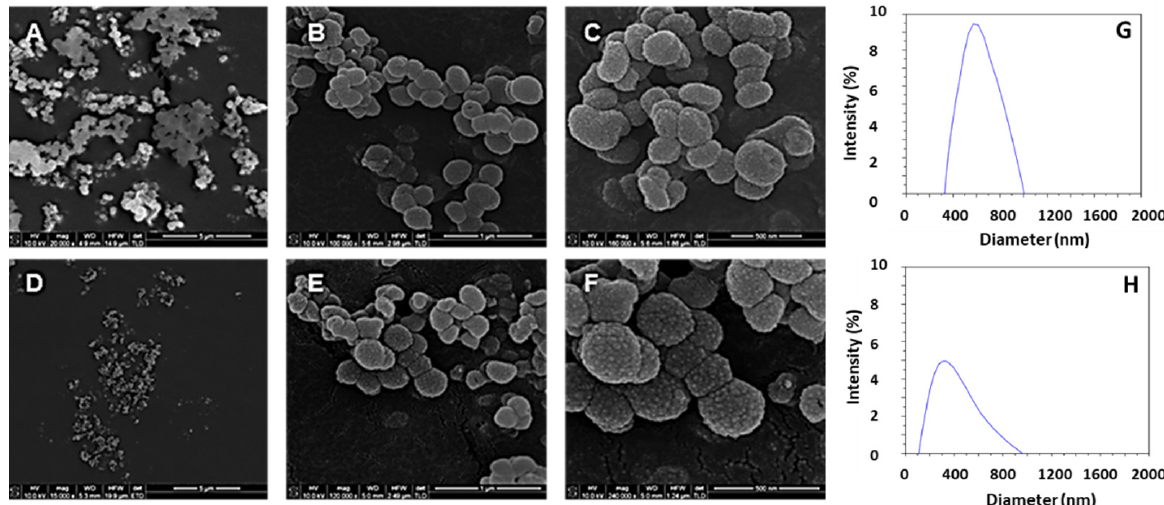
Table 1. Textural properties of the extracted and calcined Fe 3 O 4 @MSNs. Figure 5. NanoSEM images of the surface of Fe 3 O 4 @MSNs samples: Fe 3 O 4 @MSN10-c ( A – C ), Fe 3 O 4 @MSN10-b ( D – F ). Particle size distributions: Fe 3 O 4 @MSN10-c ( G ), Fe 3 O 4 @MSN10-b ( H ).